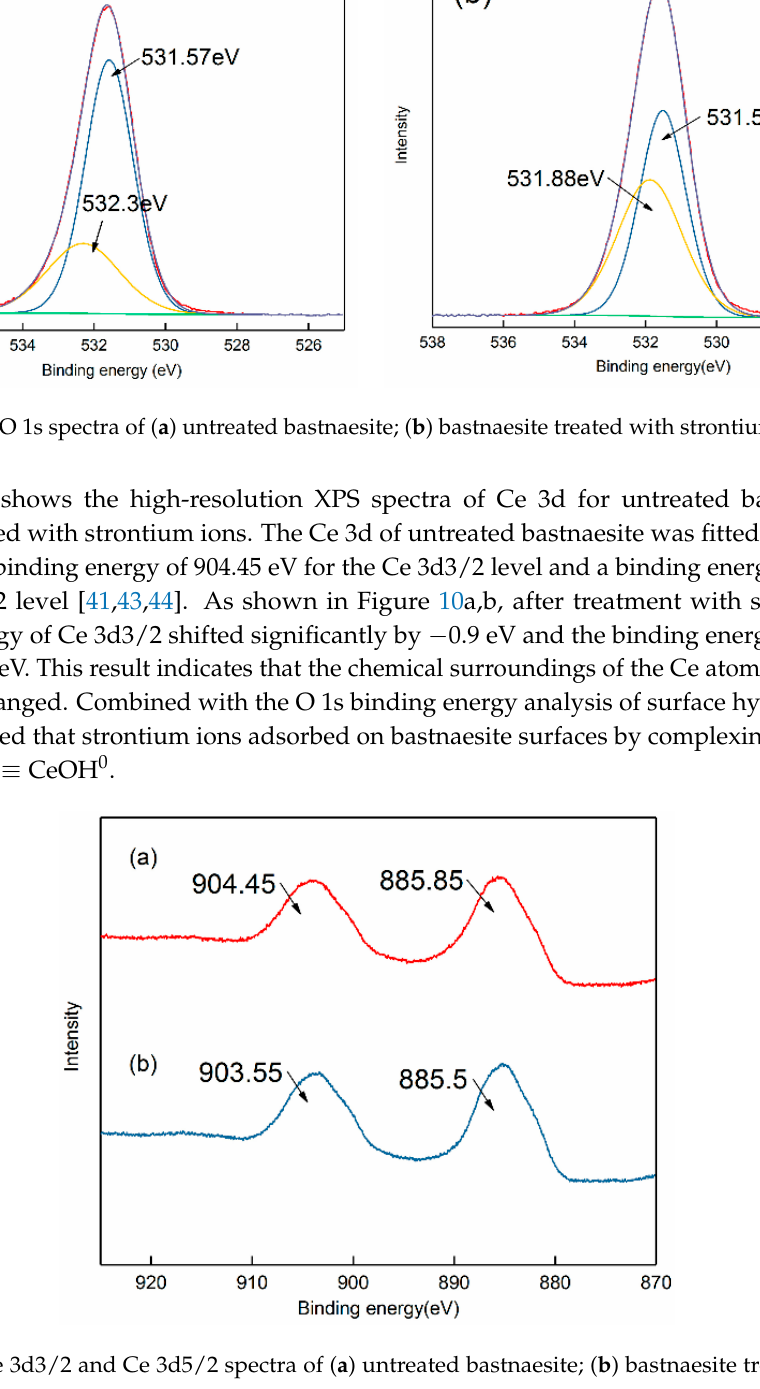
Figure 10. Ce 3d3/2 and Ce 3d5/2 spectra of ( a ) untreated bastnaesite; ( b ) bastnaesite treated with strontium ions.